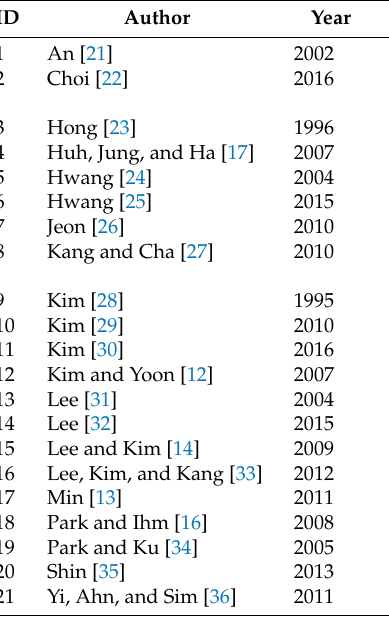
Table 1. Studies included in the